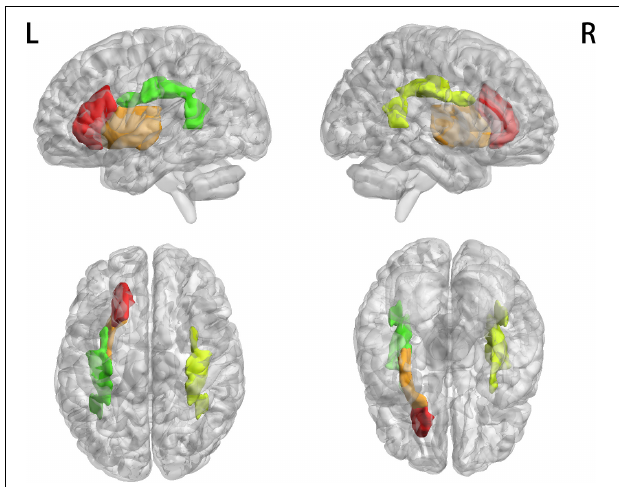
FIGURE 3 | WM bundles in the cerebrum of MNI space with decreased GM-averaged correlation coefficients. Thresholds were p < 0.05, and FDR corrected for multiple